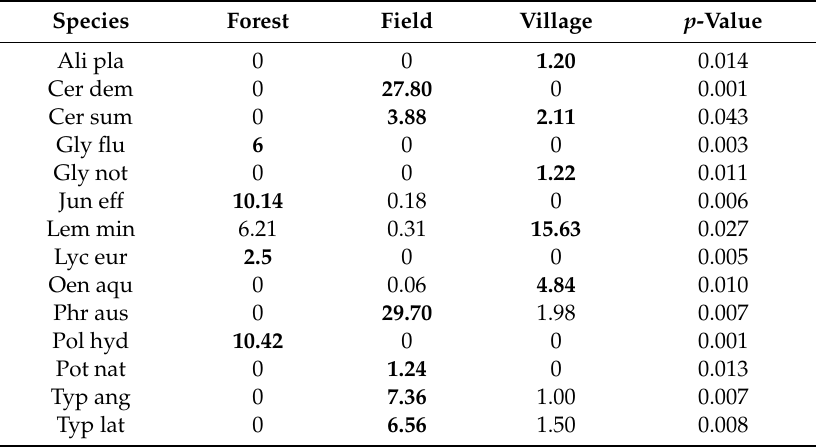
Table 5. IndVal index values for species found in ponds with di ff erent land